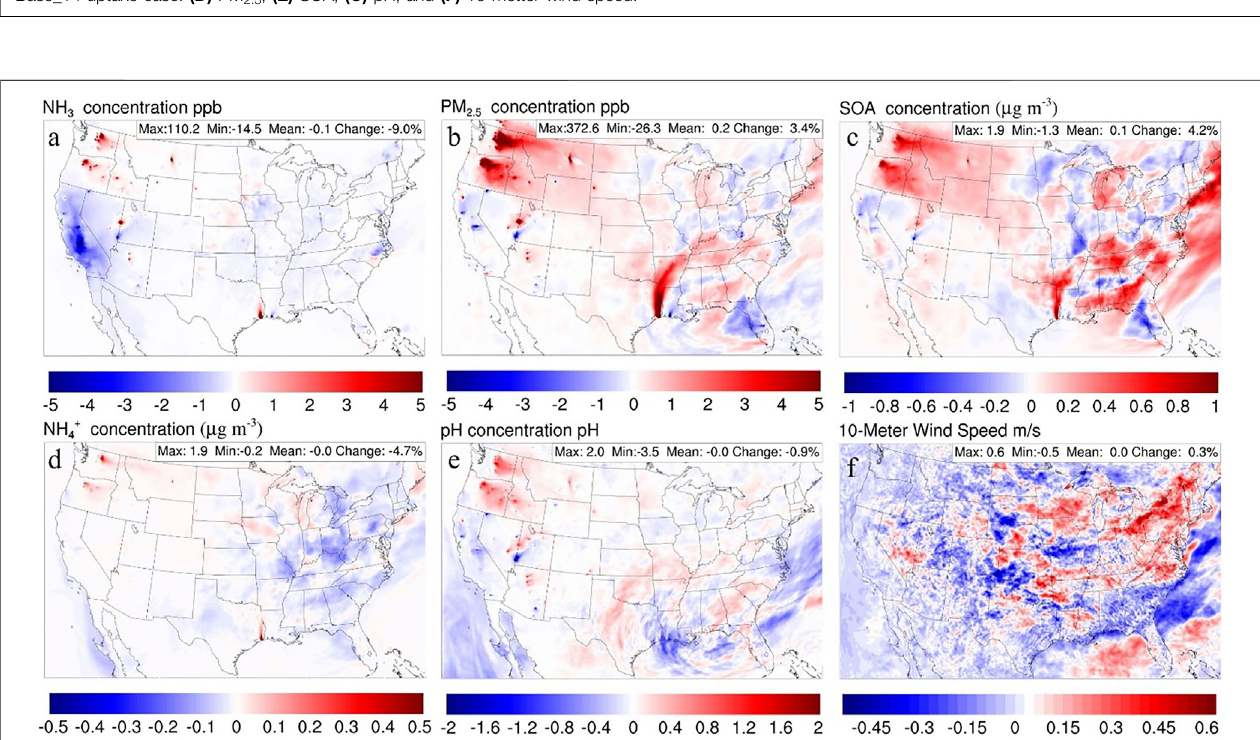
FIGURE 5 | Spatial distribution of differences between UpTk_50 and Base_50 uptake case: (A) NH 3 , (B) PM 2.5 , (C) SOA, (D) NH 4+ , (E) pH, and (F) 10-metter wind speed.